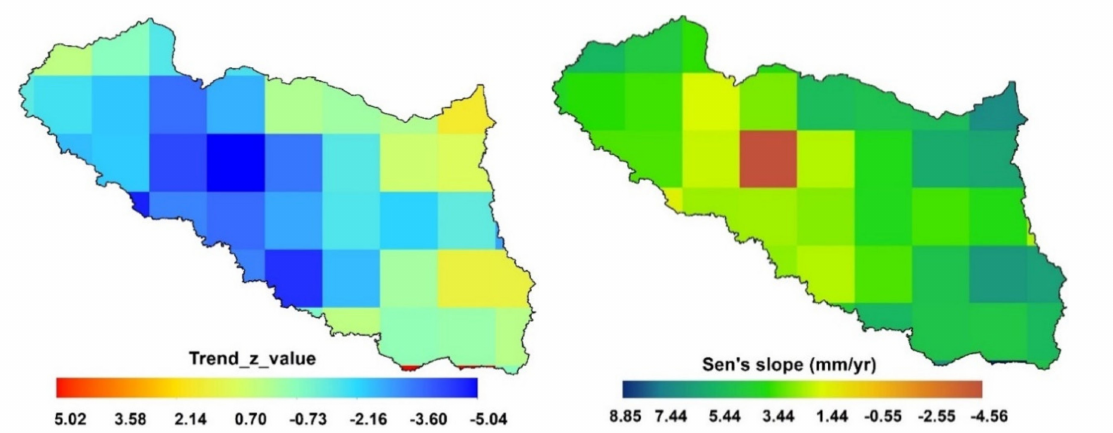
Figure 4. Spatial distribution of Sen’s slope and MK test Z statistics over the